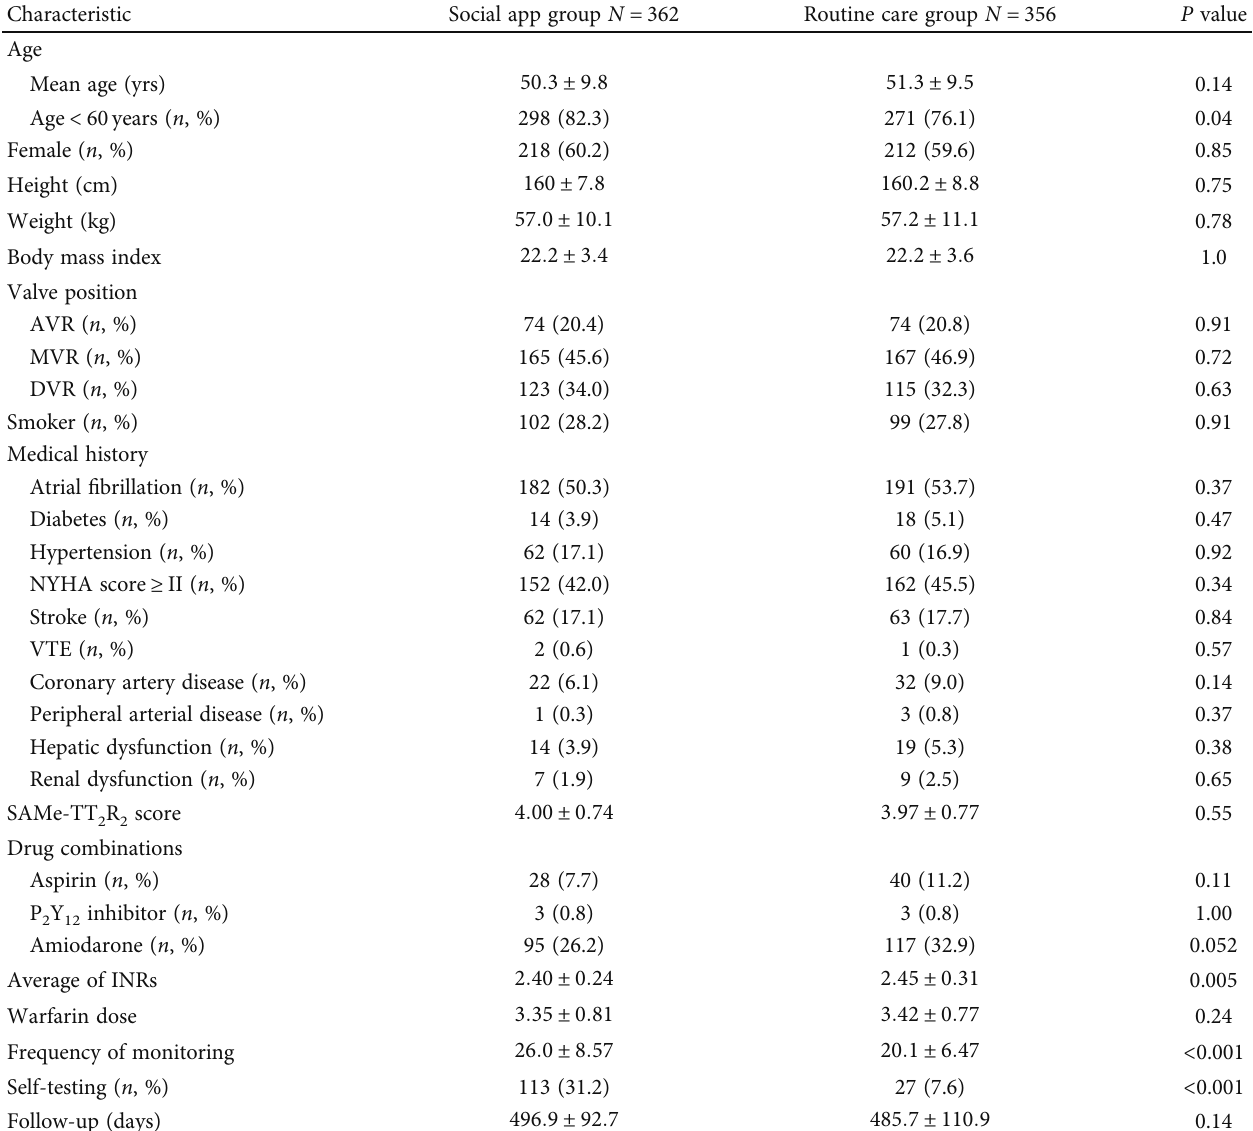
Table 1: Baseline characteristics of the